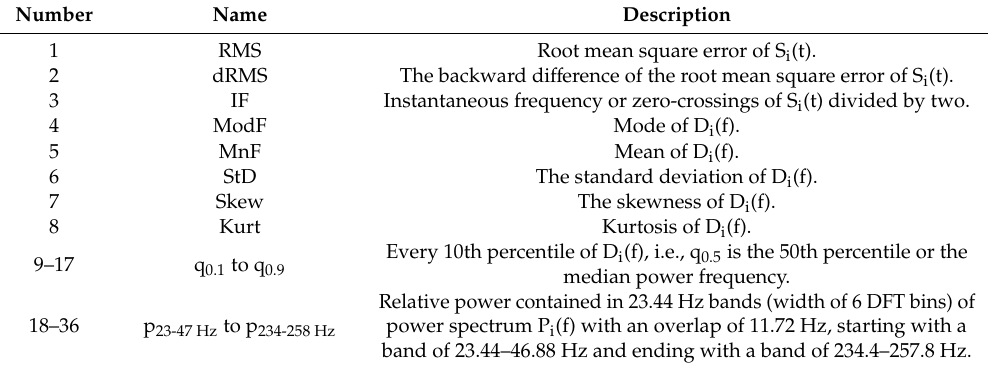
Table 1. Frequency-based features extracted from an i th segment of the surface-electromyography (sEMG) signal S i (t) obtained from each